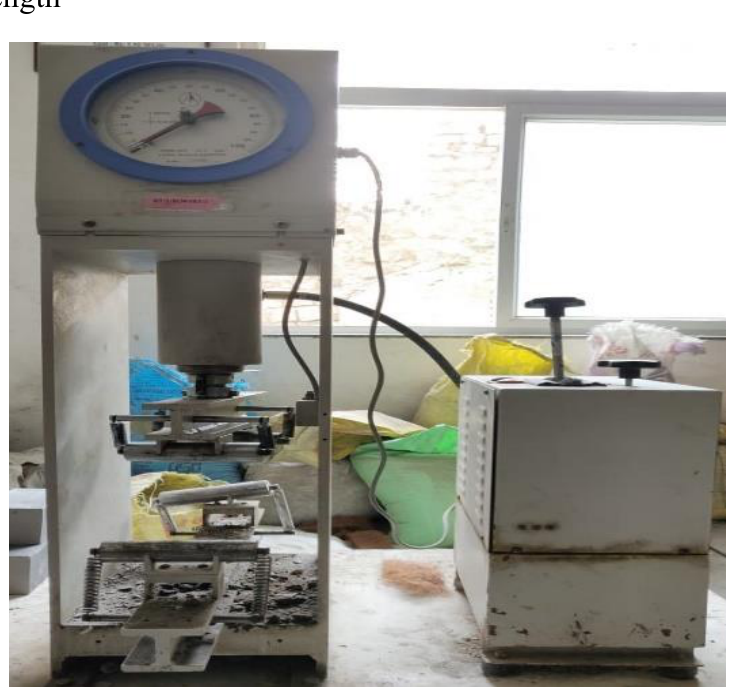
Fig. 8. specimen failed in flexural